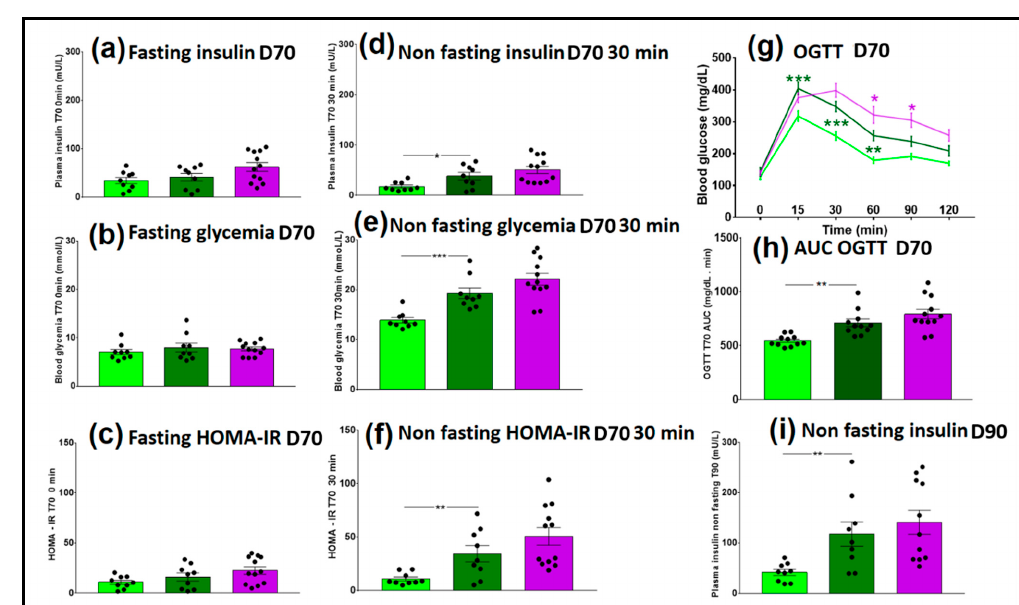
Figure 4. Glycemic and insulin resistance parameters of CD- and 2HFD-fed HR vs. NAFLR mice, n = 9–12 mice/group. ( a ) Fasting insulinemia at D70, t = 0 min Oral glucose tolerance test (OGTT); ( b ) fasting glycemia at D70, t = 0 min OGTT; ( c ) fasting Homeostasis Model Accessment of insuline resistance (HOMA-IR) at D70, t = 0 min OGTT; ( d ) non-fasting insulinemia at D70, t = 30 min OGTT; ( e ) non-fasting glycemia at D70, t = 30 min OGTT; ( f ) non-fasting HOMA-IR at D70, t = 30 min OGTT; ( g ) blood glucose follow-up during OGTT at D70; green (** p < 0.01, *** p < 0.001) is used for diet impact (HR_2HFD vs. HR_CD) and purple (* p < 0.05) is used for microbiota impact (NAFLR_2HFD vs. HR_2HFD) statistical comparisons; ( h ) AUC of the OGTT at D70; ( i ) non-fasting insulinemia at D90. HR, healthy human microbiota receiver mice; CD, control diet; 2HFD, high-fructose, high-fat diet; NAFLR, NAFL patient microbiota receiver mice; light green, HR_CD, HR mice on CD; dark green, HR_2HFD, HR mice on 2HFD; purple, NAFLR_2HFD, NAFLR mice on 2HFD; OGTT, oral glucose tolerance test; HOMA-IR, homeostatic model assessment of insulin resistance; AUC, area under the curve. D70, day 70, 7 weeks of 2HFD treatment; D90, day 90, 10 weeks of 2HFD treatment. Microorganisms 2021 , 9 , x